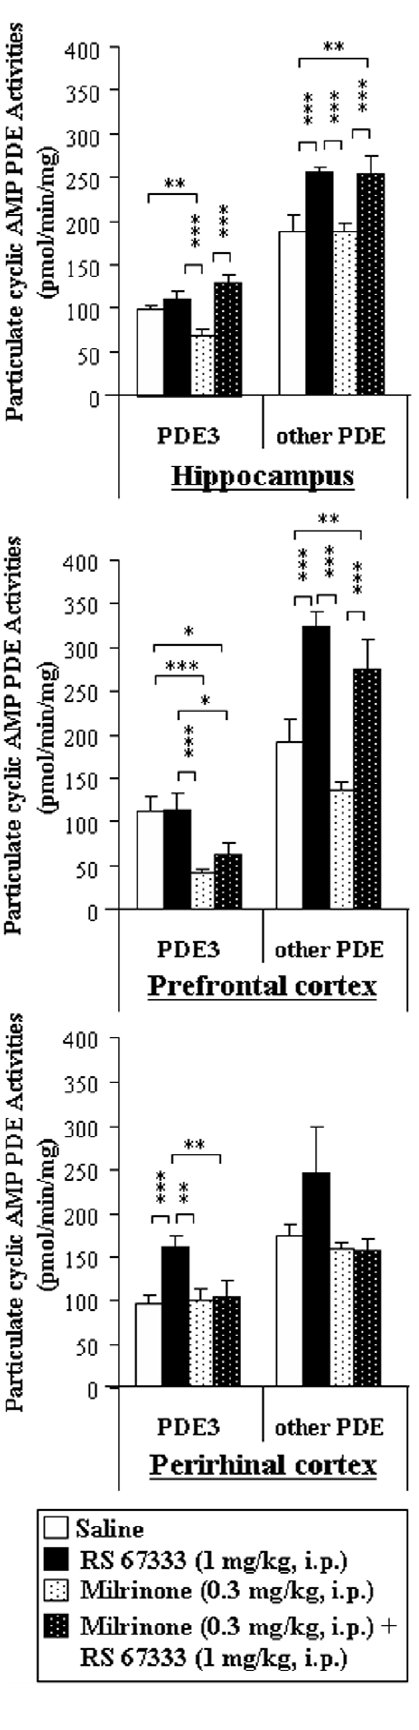
Figure 3. Milrinone (0.3 mg/kg, i.p.) specifically inhibits PDE3 activities in hippocampus, prefrontal cortex and perirhinal cortex from rats. Rats were injected with the PDE3 inhibitor (milrinone, 0.3 mg/kg, i.p.) and then with saline or the 5-HT4 receptor agonist (RS 67333, 1 mg/kg, i.p.), respectively 45 minutes and 30 minutes before the sample phase of the object recognition task. Immediately after the testing phase, both particulate and soluble fractions from the hippocampus, the prefrontal cortex and perirhinal cortex were isolated and particulate fraction was assayed for milrinone (20 m M)-sensitive PDE activities. Milrinone-sensitive and –insensitive PDE activities were expressed as pmolcAMPhydrolysed/min/mg protein. Results are means 6 SEM of four independent subcellular fractionations performed in triplicate. Within each subcellular compartment, * indicated significant differences of PDE activity as compared with test).